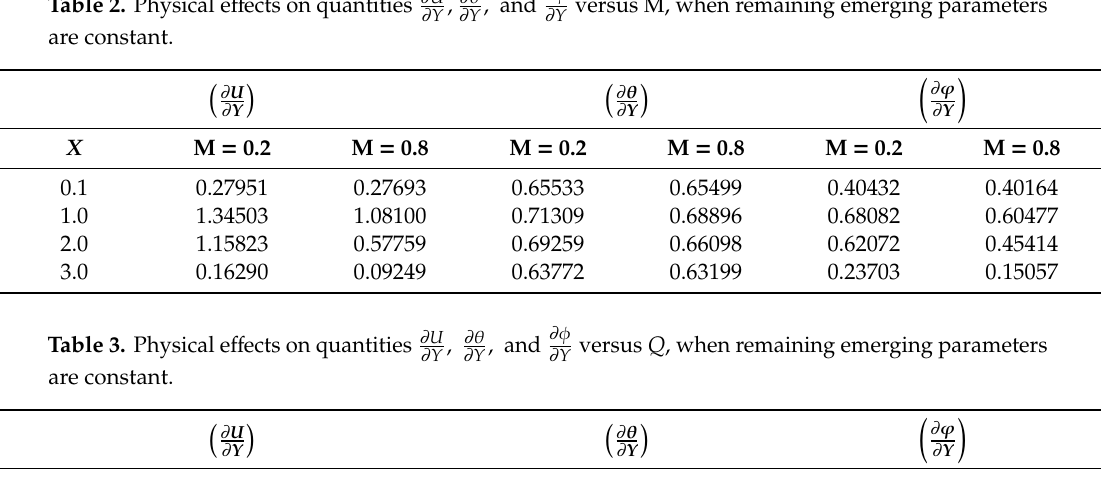
∂φ ∂θ , ∂ Y , and ∂ Y versus M, when remaining emerging parameters Y